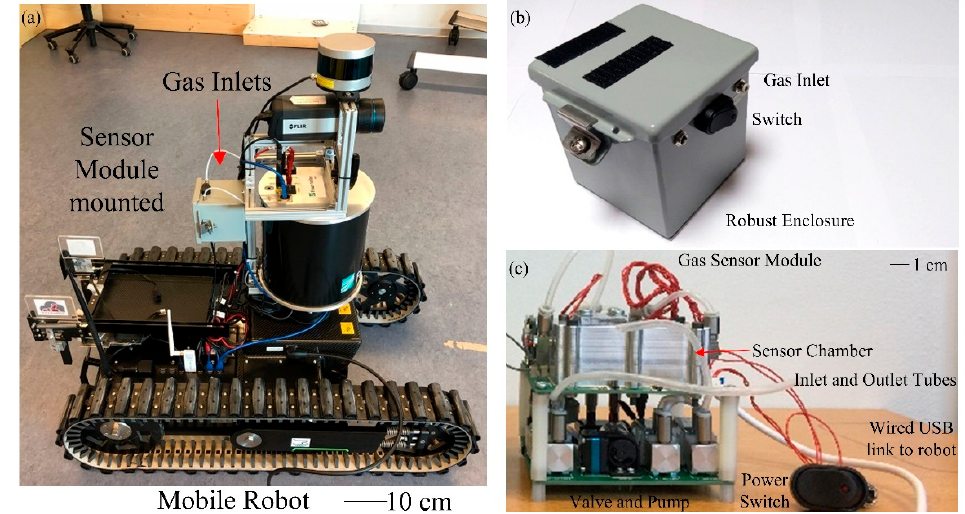
Figure 1. Photographs showing robust gas sensor module, ( a ) module installed on tracked exploration robot, ( b ) steel enclosure holding sensor module with inlet for gas sampling, and ( c ) internal components of the sensor module, stack PCB design, upper board contains low power sensor components, and lower board contains flow control circuitry (pump, valves and flow sensor).